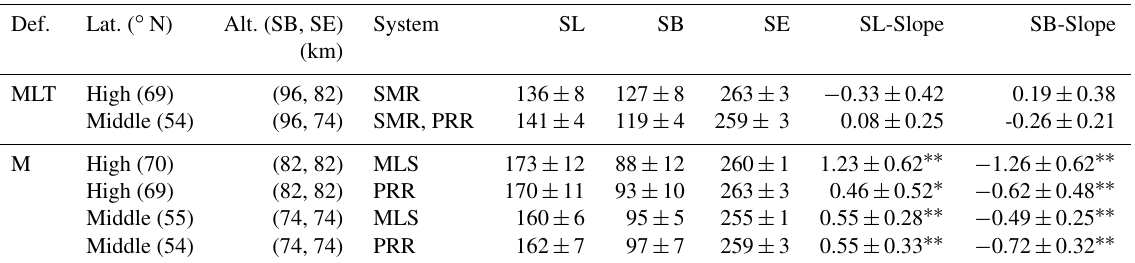
Figure 3. Summer length at high latitudes: on the left is shown MLT-SL and M-SL on the right: panel (a) represents the summer beginning at 96km (MLT-SB) and panel (e) 82km (M-SB) for each year (abscissa) and the DOY when the mean zonal wind reversal occurs (ordinate). The summer end is measured at 82km for both (b) MLT-SE and (f) M-SE. Panels (c) and (g) depict the summer length as the difference between summer end and summer beginning, i.e., MLT-SL and M-SL, respectively. For each time series a linear fit is shown in the same color with the standard deviation of the slope in the same color with dashed lines. The panels in the last row (d, h) show proxies of lower and extraterrestrial atmospheric forcing (see text for details). Table 1. Summary of the mean values and their standard deviations for each time series with the corresponding values of the slope from the linear fit and confidence values (cv) divided into three categories: less than 80% without a star, greater than 90% with one star and greater than 95% with two